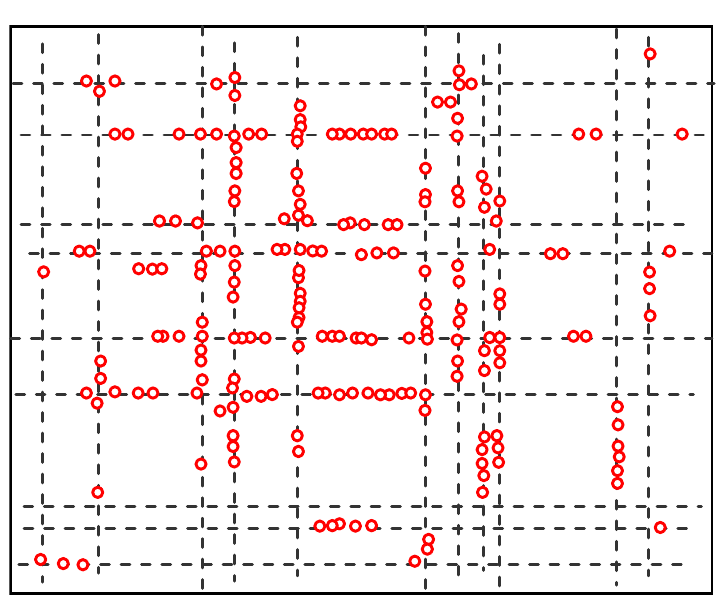
Figure 5. Node distributions at 12 AM.